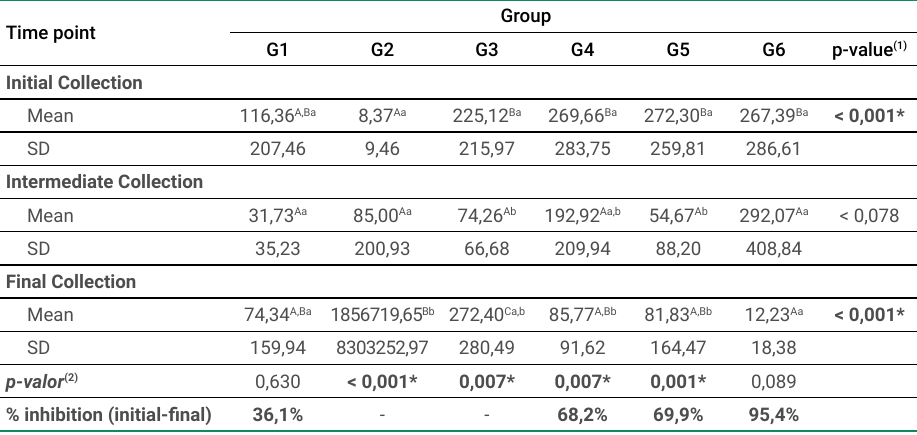
Table 2. Comparison of bacterial load at 3 assessment time